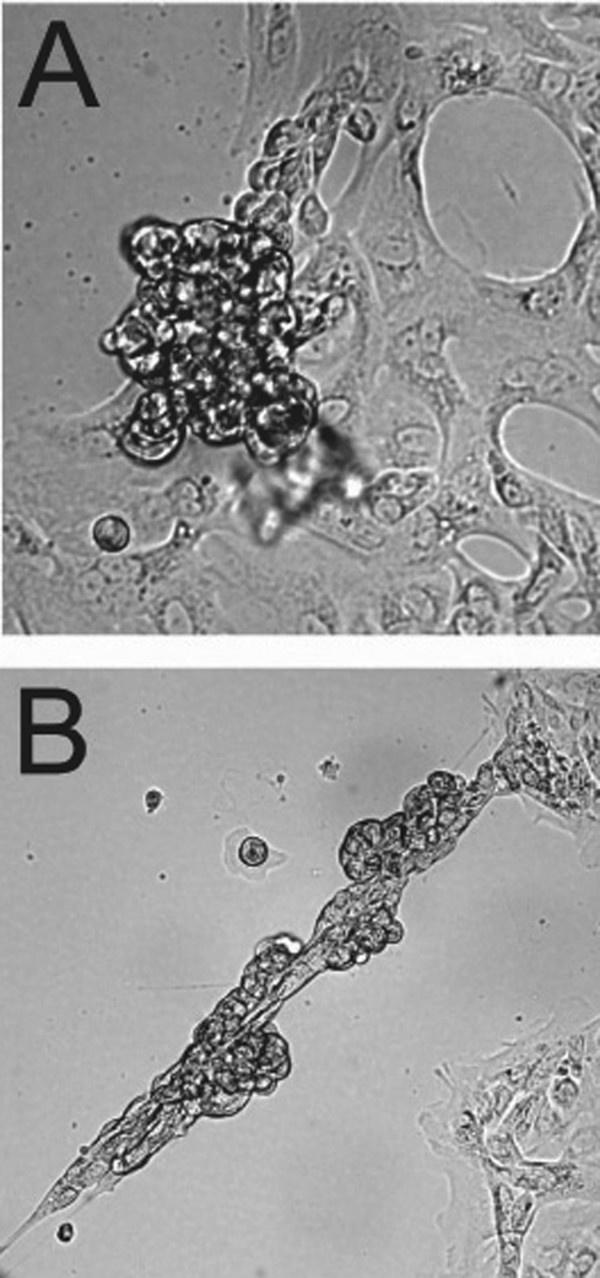
Micrographs of the non-diseased primary human mammary epithelial cultures (HMEC) from the BRCA1 mutation carrier. A) Contralateral breast – A cluster of epithelial cells called a mammosphere is shown on the left center of the image sitting on a field of fibroblasts. B) Ipsilateral breast – The original fresh tissue block from which this culture was derived was located 4 cm from the infiltrating ductal carcinoma. The structure shown is a cluster of rounded epithelial cells manifesting a column configuration called "pre-ductal linearization". Both images were captured under Differential Interference Contrast (DIC) optics on a Zeiss Axiovert 100 microscope at a total of 140x magnification.